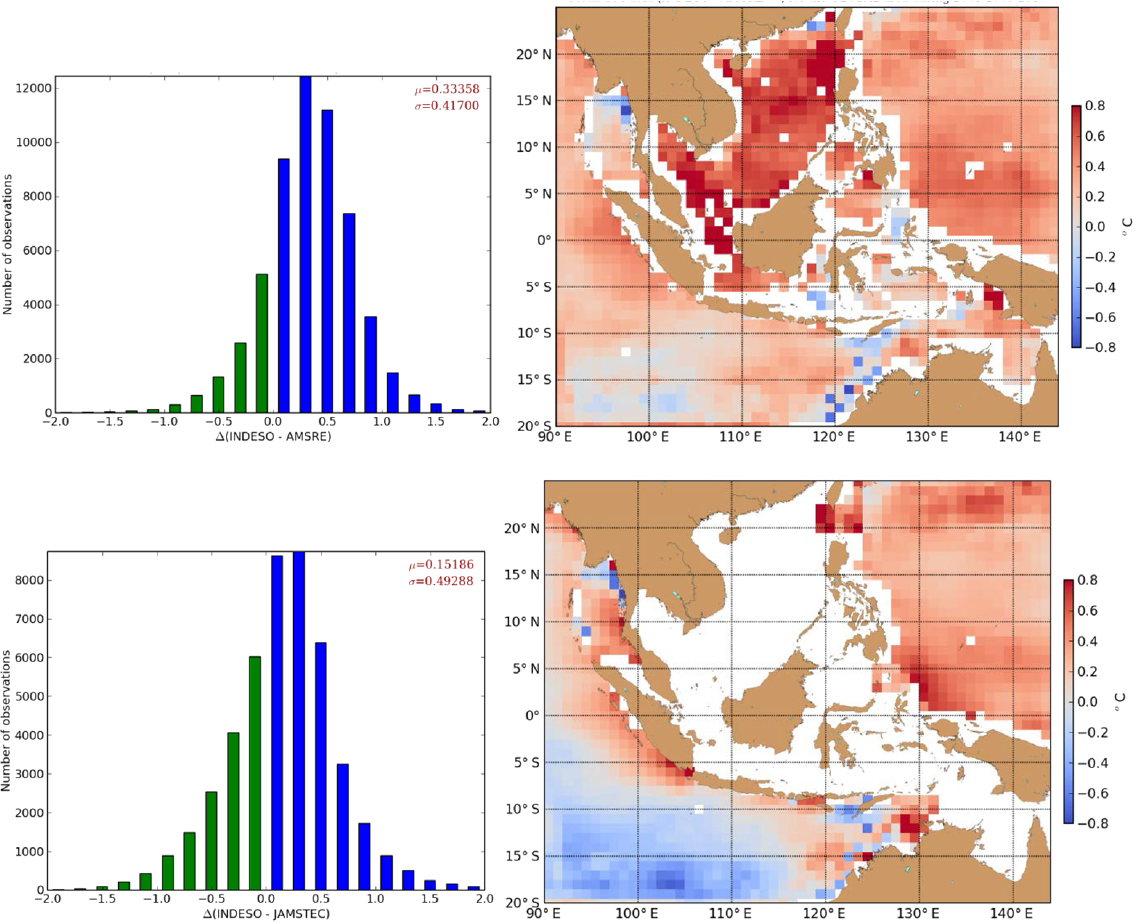
Figure 10. Mean bias ( ◦ C) of the INDO12 SST (monthly means) relative to AMSR-E (V7.0) (top) and JAMSTEC (ARGO + TRITON + CTD) (bottom) for the years